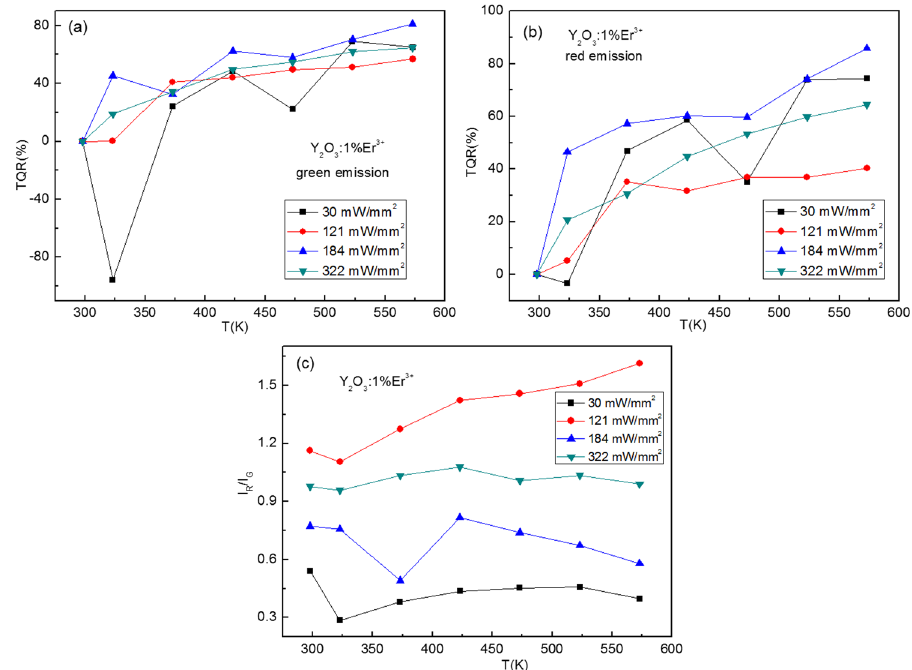
Figure 10. Excitation powers dependent TRQ of ( a ) green and ( b ) red emissions of Y 2 O 3 :1%Er 3 + , and ( c ) red to green intensity ratio of Y 2 O 3 :1%Er 3 + .